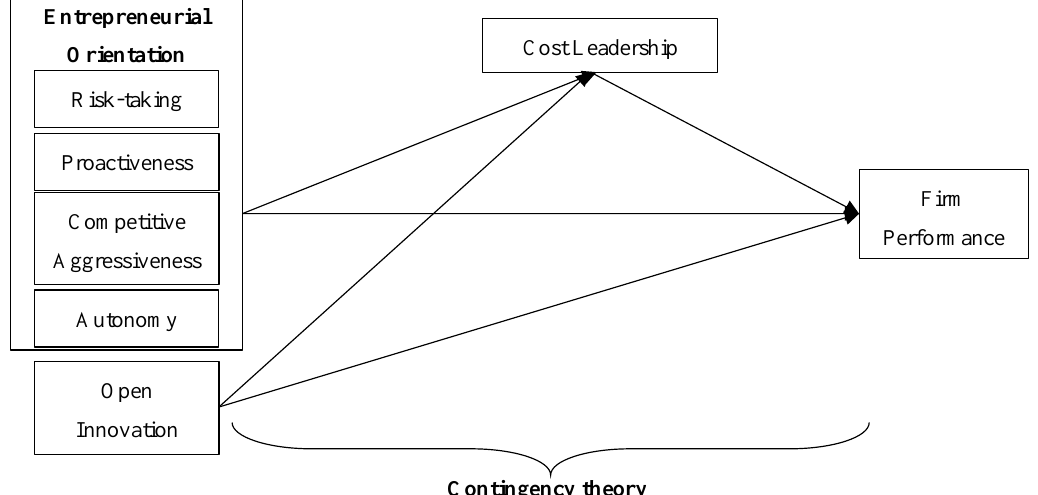
Figure 1. Theoretical framework.